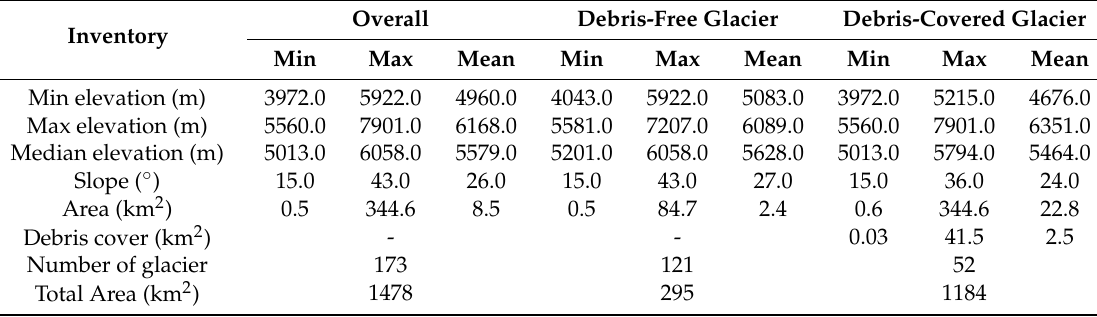
Table 4. Topographic parameters of glaciers based on the glacier inventory 2014.